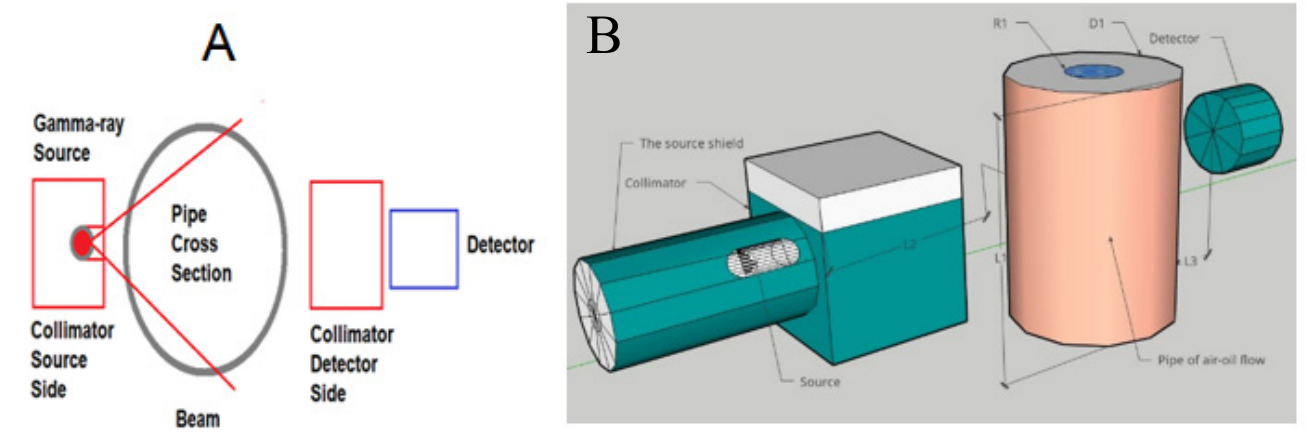
Figure 3 . ( A ) Gamma-ray technique for multiphase flow measurements. ( B ) Simulation of gamma-ray attenuation sensor .